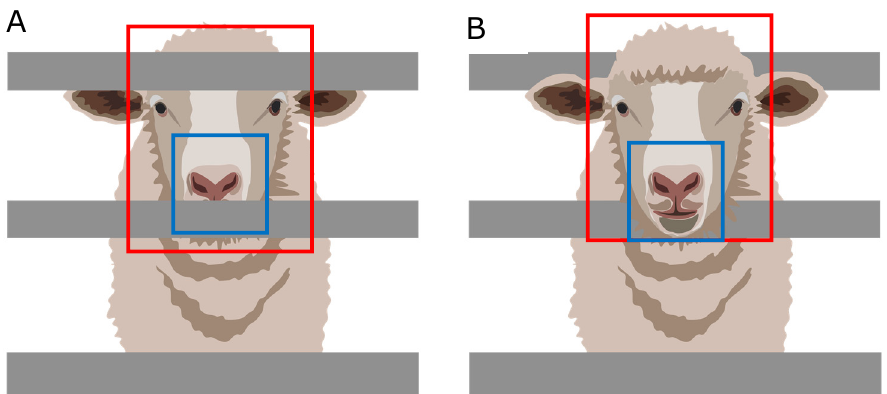
Figure 8. Examples of sheep with head and features tracked as region of interest (ROI) for the head (blue rectangles) for infrared thermal video (IRTV) analysis and nose / mouth regions (blue rectangles) for heart and respiration rates analysis from RGB video analysis behind bars ( A ) and through the bars ( B ) of cages.